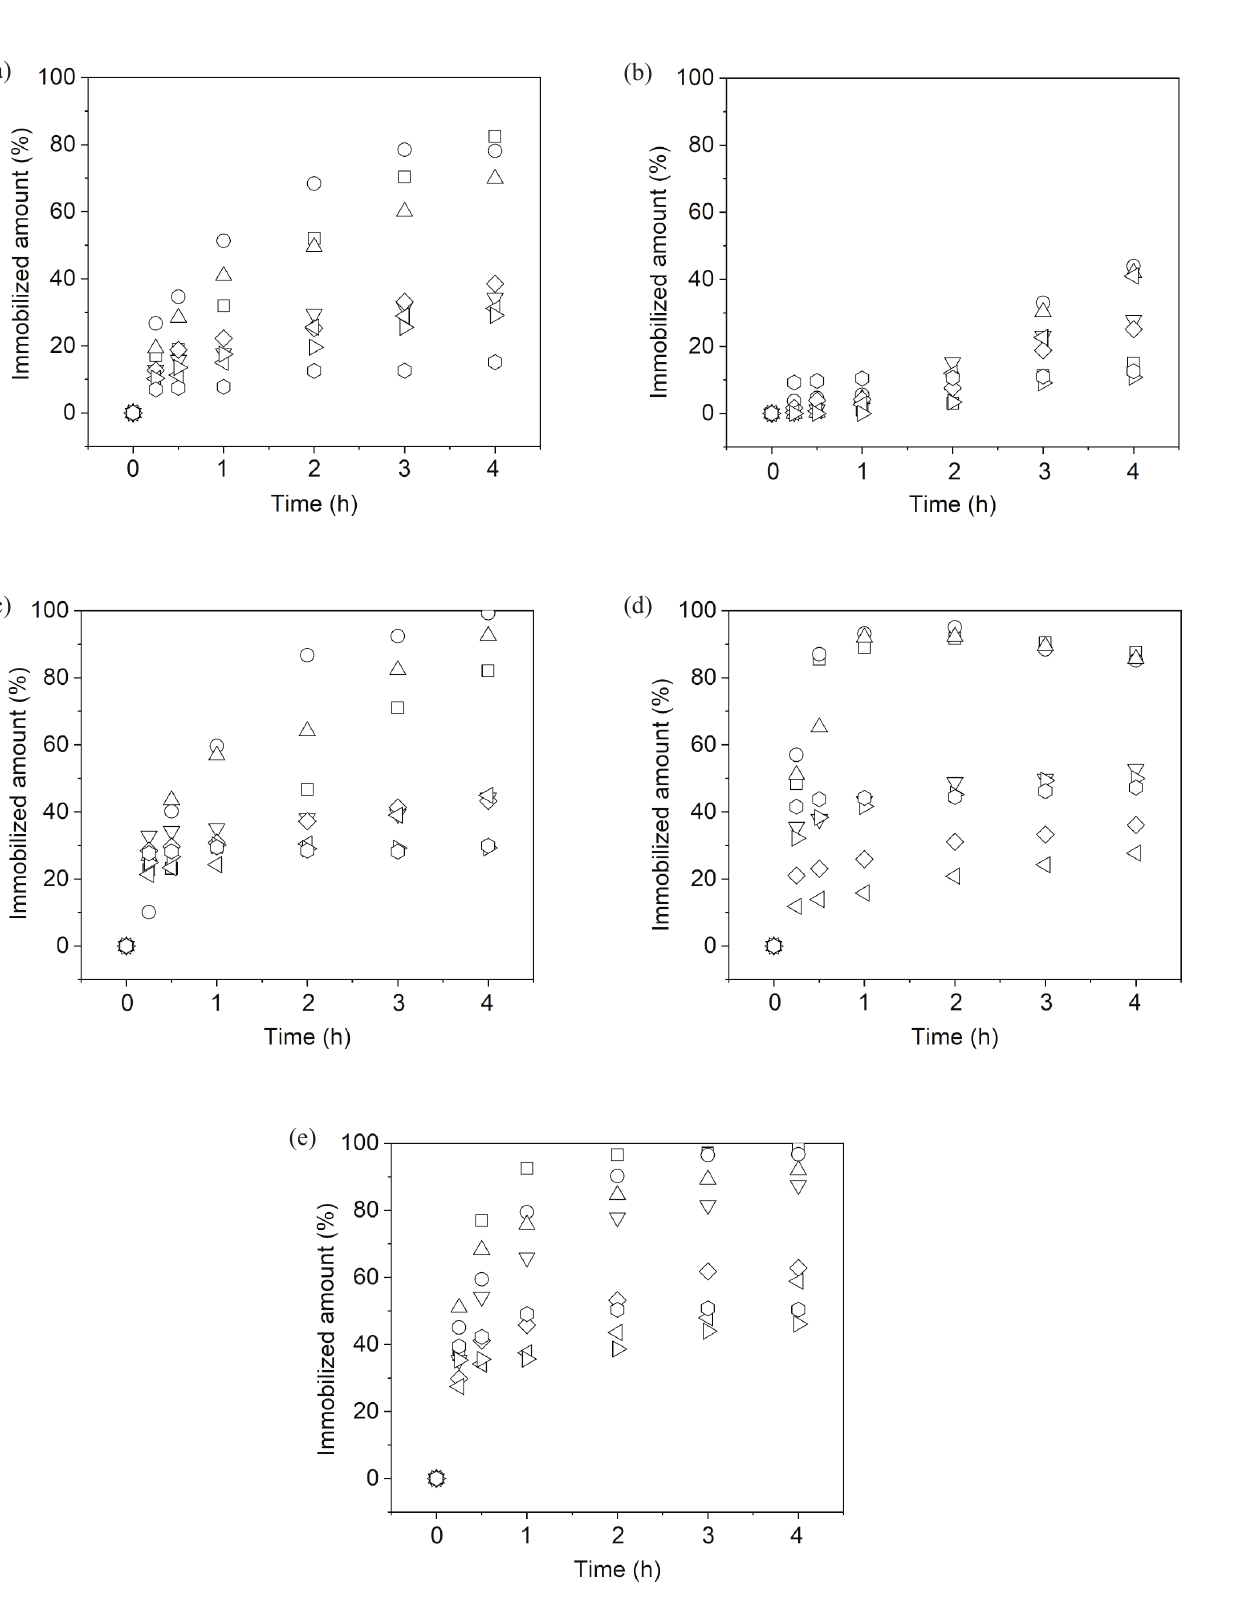
Fig. 6 – Immobilization course of different substances and materials – paracetamol (a), ascorbic acid (b), salicylic acid (c), ibupro- fen (d), and nicotinic acid (e); Mg-Al 2:1(square), Mg-Al 3:1 (circle), Mg-Al 4:1 ( triangle), Zn-Al 3:1 (bottom triangle), Mg-Fe 2:1 (diamond), Mg-Fe 3:1 (left triangle), Ni-Mg-Al 1.5:2.5:1 (right triangle), Ni-Mg-Al 1.5:1:1